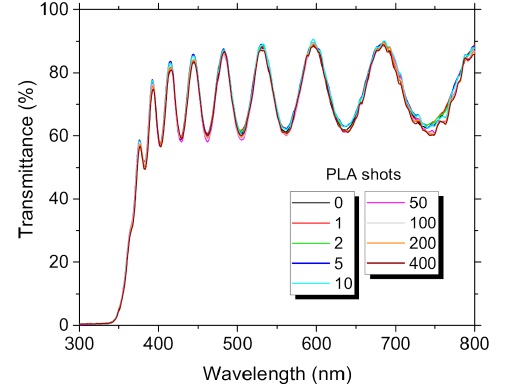
Figure 7. Transmittance spectra TiO 2 :Eu thin film, dependence on the number of PLA shots.